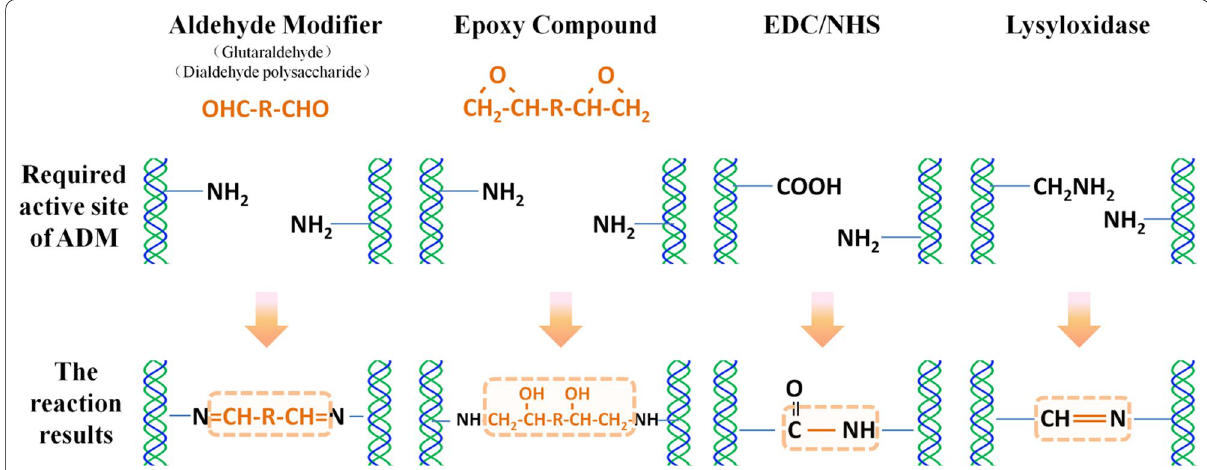
Fig. 1 Schematic diagram of reaction of several common modifiers with